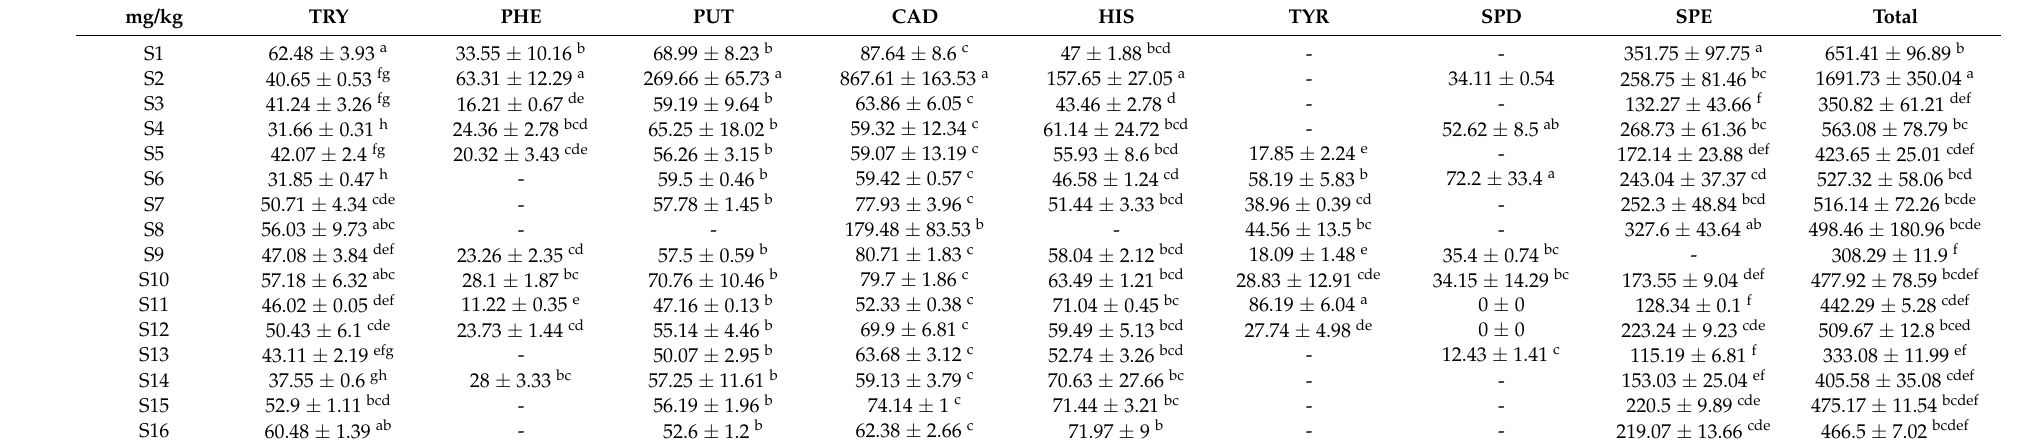
Table 2. Biogenic amine concentration in jerky